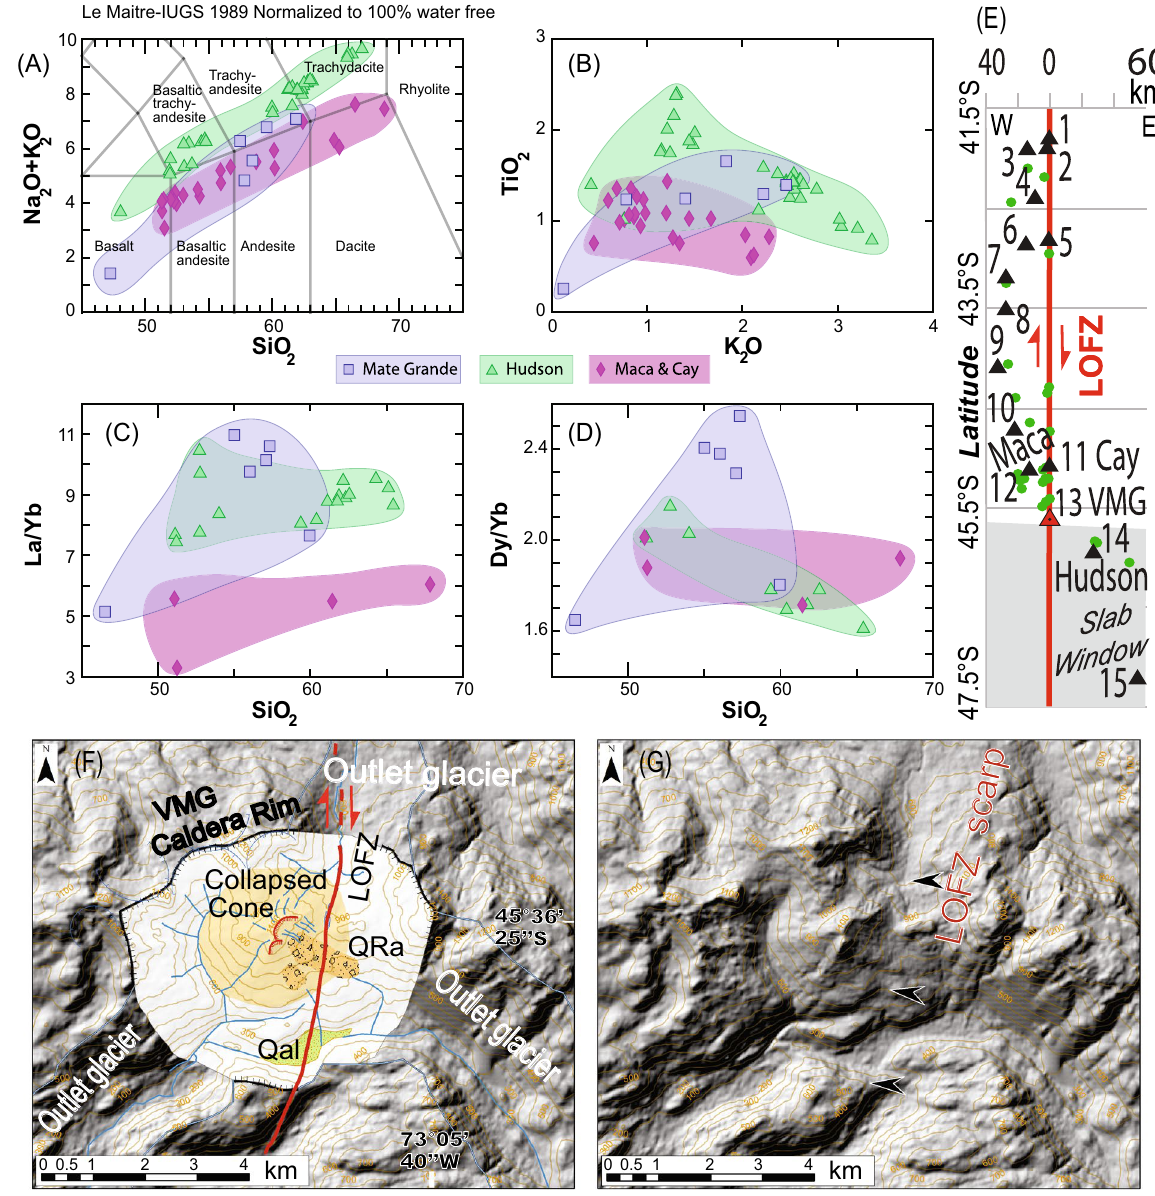
Figure 3. ( A ) Volcan Mate Grande (VMG: discovered during this study; 45° 35 ′ 28 ″ S, 73° 07 ′ 51 ″ W) has Hi-K calcalckaline magmas and ( B – D ) distinct geochemical characteristics compared with Volcan Maca and Cay complexes ( 32, 33 ; VMCC: typical SVZ magmas) and Volcan Hudson (VH; atypical SVZ magmas). VMG has distinctive La/Yb ( C ) and Dy/Yb ( D ) values, i.e. a completely different signature between VMG magmas and VH magmas. ( E ) Distribution (perpendicular distance (km) and normalised along-strike of the LOFZ) of stratovolcanoes and monogenetic cones from 41.5° to 47.5° S based on our mapping. ( F , G ) DEMs and mapping from the VMG, showing the 5 km by 4 km caldera, the young partially collapsed cone, the rock avalanche deposits (QRa), Quaternary alluvium (Qal), and the location of the main trace of the LOFZ that cuts this cone and displaces the rock avalanche deposit (likely triggered by a LOFZ earthquake/rupture) northward (i.e. dextrally) by ~ 170 ± 20 m. Base hillshade was generated with Esri ArcMap v.10.3 software (under fair terms of use, https:// www. esri. com/ en- us/ legal/ copyr ight- trade marks) 39 using a digital elevation model downloaded from ALOS PALSAR Global Radar Imagery 40 with 12.5 m resolution (https:// asf. alaska. edu/ data- sets/ sar- data- sets/ alos-